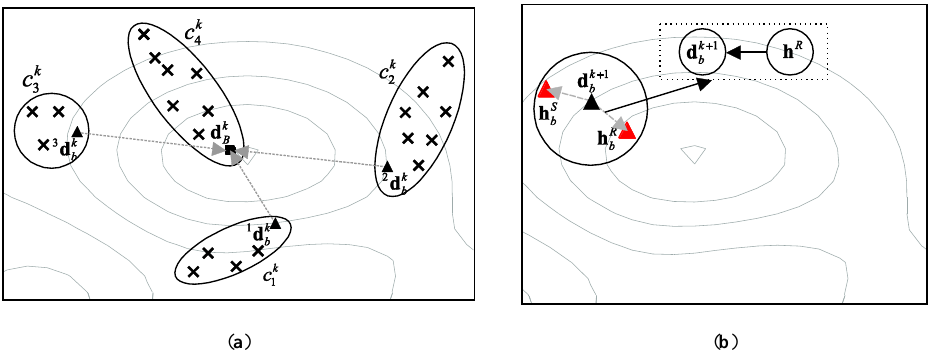
Figure 3. Extracluster procedure for ( a ) global attraction and for ( b ) global perturbation. The following pseudo-code in Algorithm 1 summarizes the entire iteratively process of the CCO.